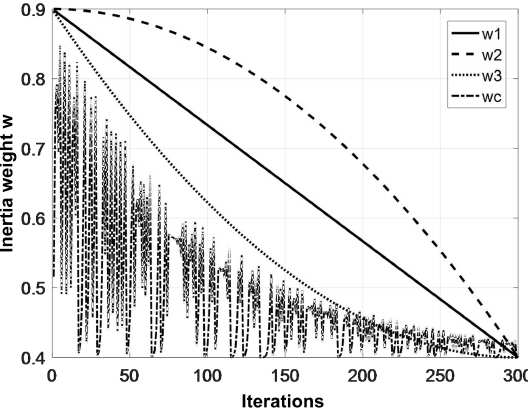
Figure 1. Inertial weight curves comparison.